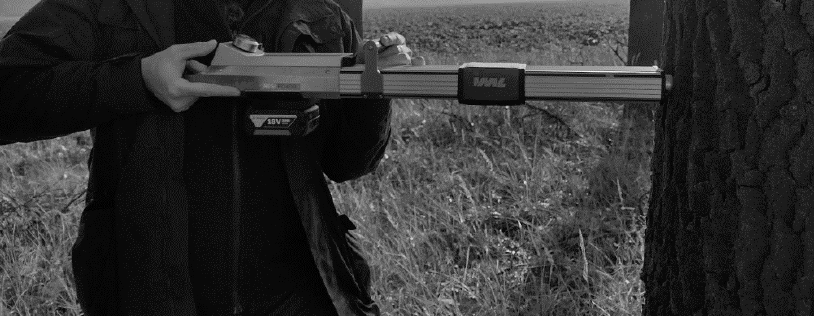
Figure 1. Resistance amplitude testing using the IML-RESI Power Drill 400.